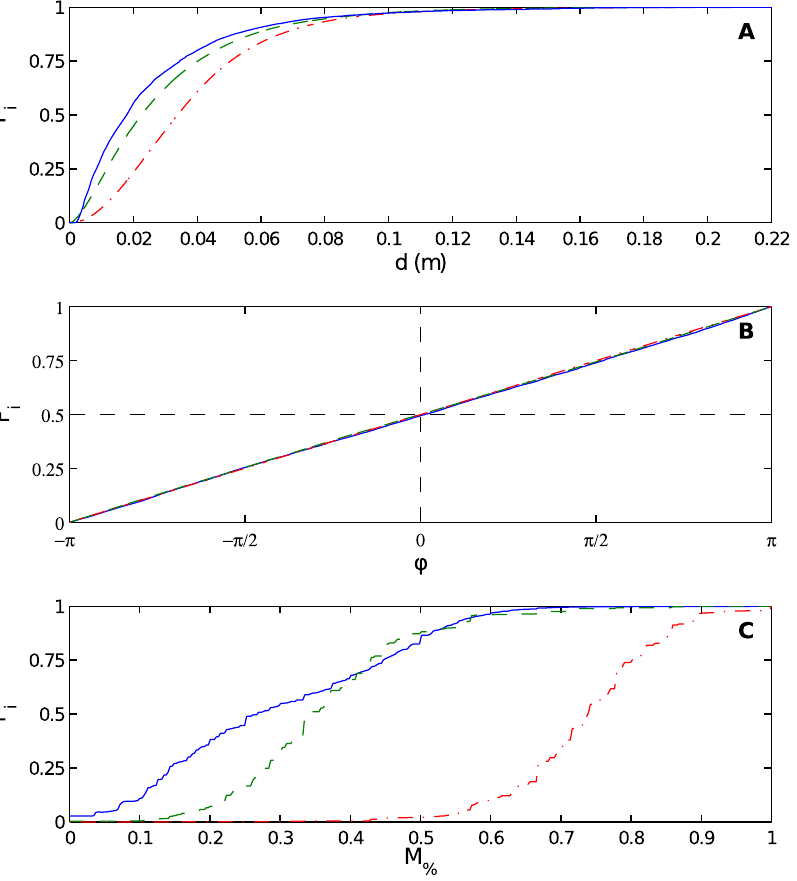
Figure 6. Pea aphid group-level behaviors in experiment, a social interaction model, and a control (non-interacting) model. (A) Cumulative distributions F i of distance to nearest neighbor d (in m ) for experimental data set (solid blue), social interaction model (dashed green), and non-interacting model (dot-dashed red). (B) Like (A), but the cumulated quantity is angle to nearest neighbor w (relative to an aphid’s heading H ). (C) Like (A), but the cumulated quantity is M % , fraction of the aphid population moving in a given frame. As compared to the curves in (A) and (B), the more staircase-like appearance of these curves arises simply from the fact that the variable being cumulated is discrete (percentage of aphids in a group of several dozen) as opposed to the continuous variables in (A) and (B). For (A)–(C), measures of the difference between the distributions are given in Tables 1–3 respectively.